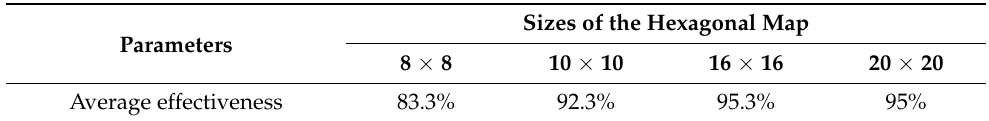
Table 8. Comparison of the effectiveness of the SOM-based classifier with the neighbourhood radius equal 2 and the linkdist function for various sizes of the hexagonal map. Table 9. Comparison of the effectiveness of the SOM-based classifier for the 10 × 10 hexagonal map and the linkdist distance function for different values of the neighbourhood radius, and for different distance function with the neighbourhood radius equal to 2.